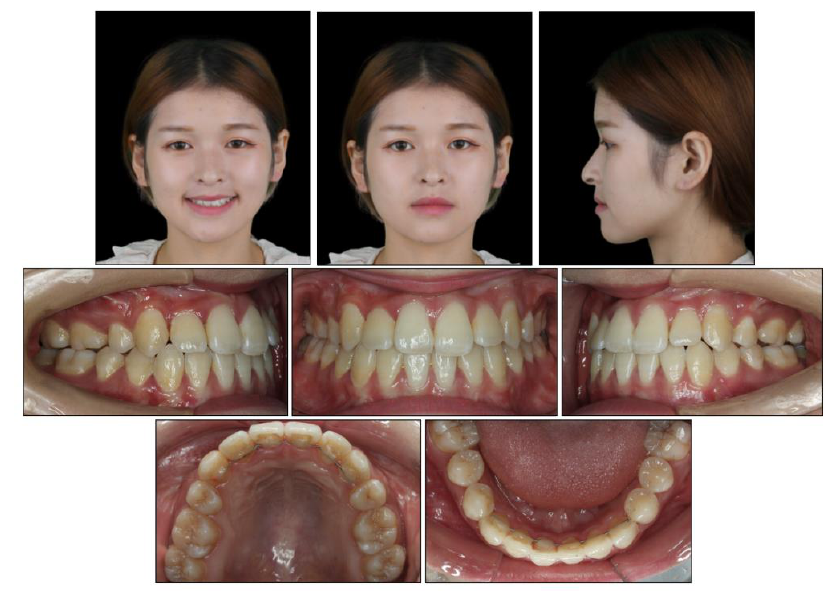
Figure 10. Facial and intraoral photographs after the 8-year follow-up.